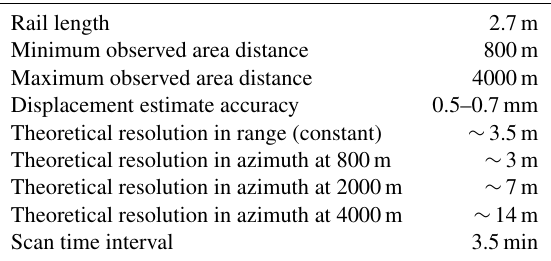
Table 1. Operational parameters set up for the GB-InSAR monitor- ing of the Montaguto